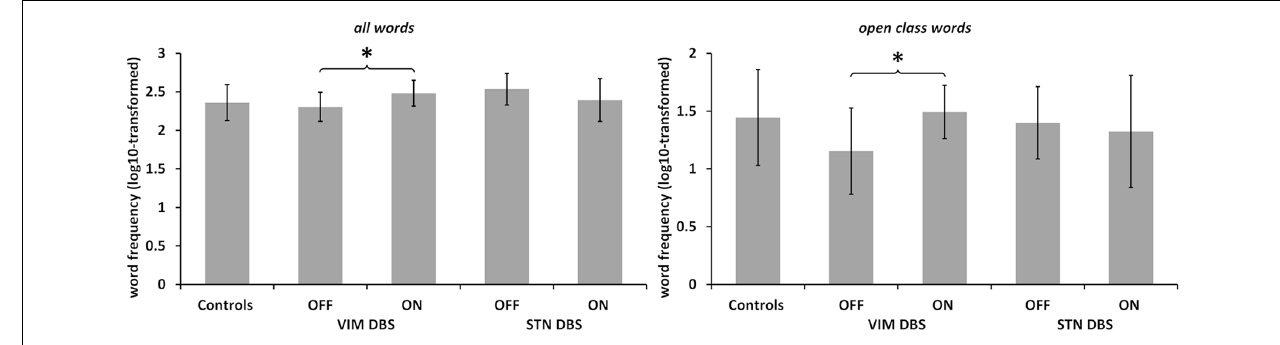
FIGURE 2 | Word frequency. Log 10 -transformed word frequency in controls and both patient groups in DBS ON and OFF conditions as noted. Note the different scaling. Values are group averages with error bars indicating standard deviations. Significant ( p < 0.05) comparisons between Controls and the DBS groups or between stimulation conditions are marked with